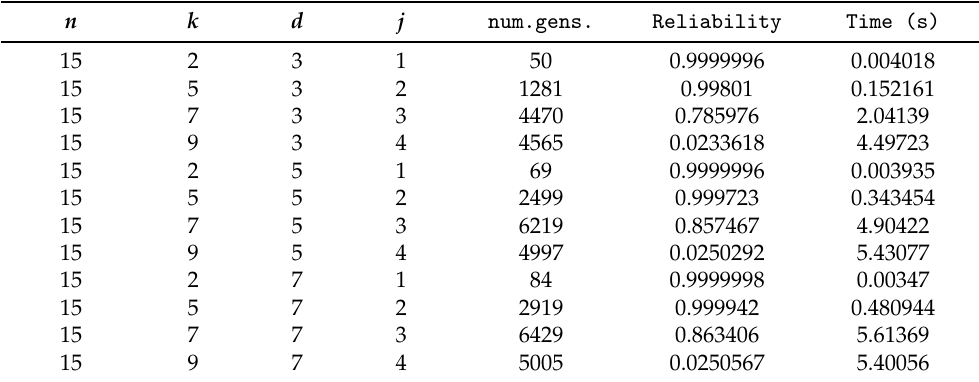
Table 3. Number of generators of the ideals of several multi-state consecutive k -out-of- n :G systems with sparse d and times to compute their